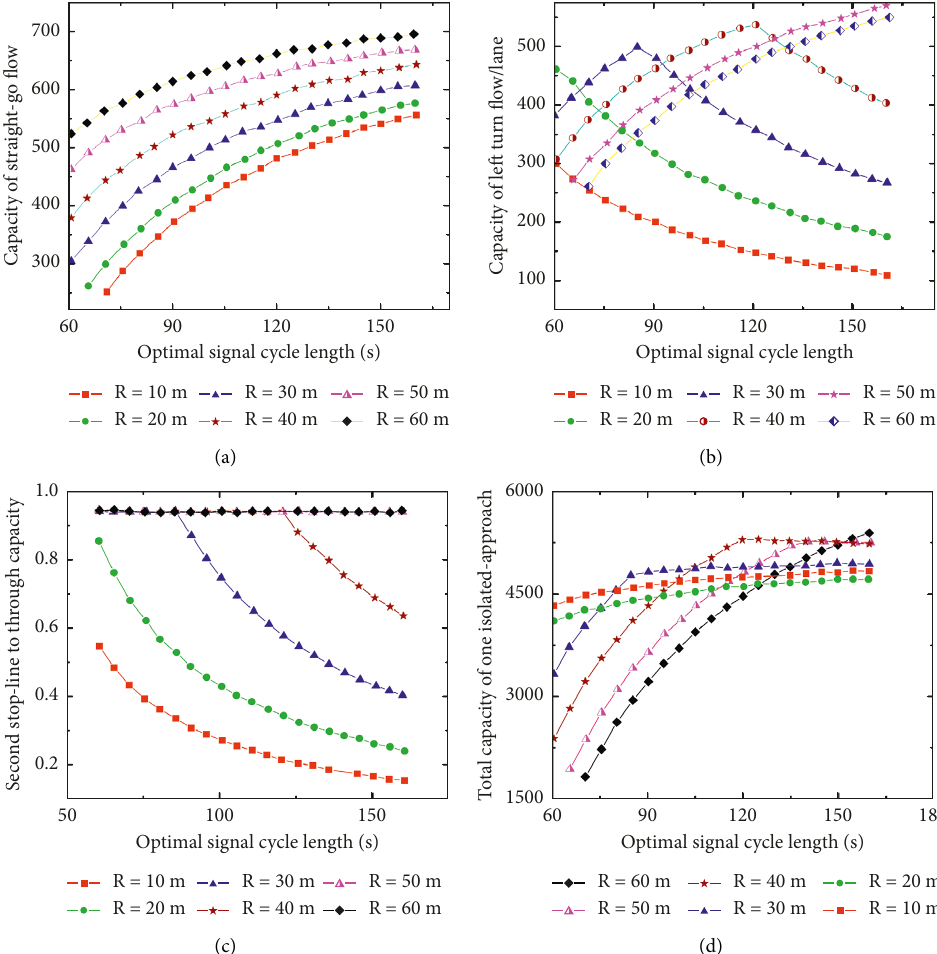
Figure 6: Model sensitivity analysis under different signal cycles and radius. (a) Capacity of straight-go flow. (b) Capacity of left-turning flow/lanes. (c) Second stop-line to straight-go flow. (d) Overall capacity of one approach